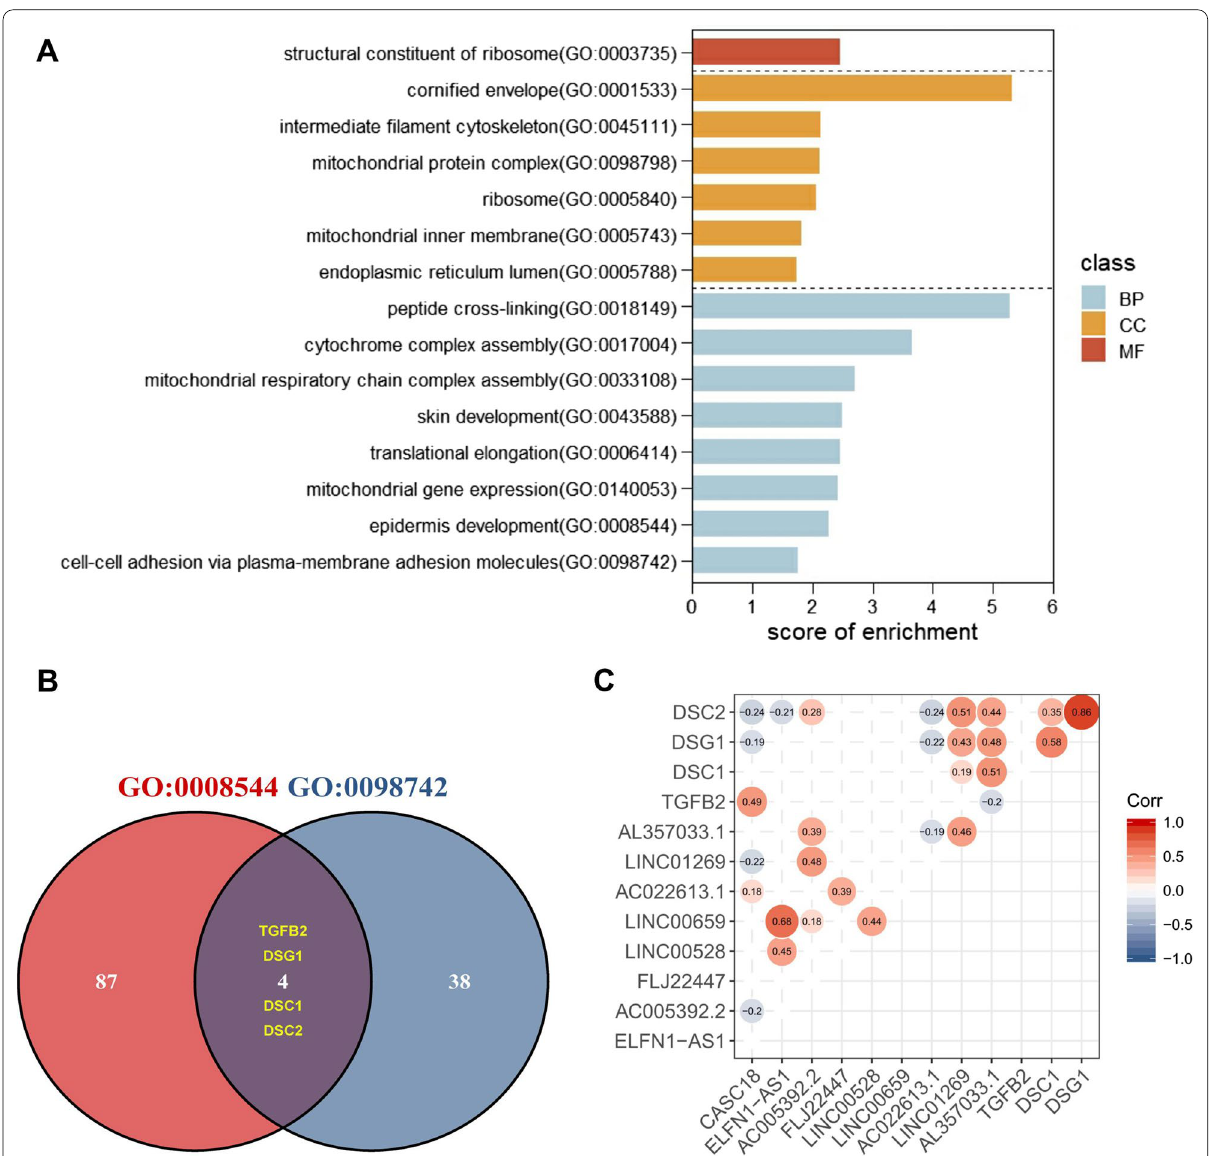
Fig. 2 Functional enrichment and correlation analyses of candidate lncRNA-related PCGs A Enriched GO terms of candidate lncRNA-related PCGs were visualized as a bar graph. BP meant biological process, CC meant cellular component, and MF meant molecular function. B Schematic illustration exhibiting overlap of enriched PCGs. Red represents genes enriched in GO: 0008544, and blue represents genes enriched in GO: 0098742. C Corrplot presentation of correlation between 9 lncRNAs and 4